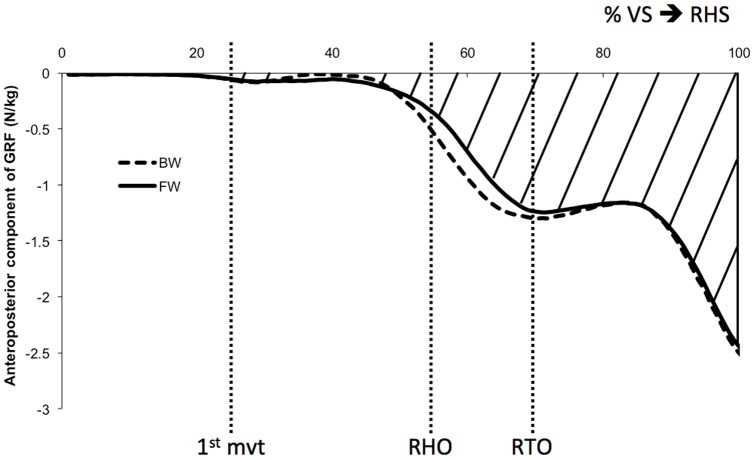
Antero-posterior component of the ground reaction force under the stance limb (left) for the BW group (dashed line) and the FW group (solid line).It was normalized temporally between the appearance of the visual signal (VS) and the right heel strike (RHS), and in amplitude in terms of the subjects' body mass. The hatched surface illustrates the antero-posterior impulse for the FW subjects, using the surface calculated under the curve between the first variation of the ground reaction force and the right heel strike. 1st mvt: first knee movement (26% of the motor task); RHO: right heel off (55%); RTO: right toe off (68%). The average standard deviations for the BW and FW subjects are 0.1 N/kg. There is no significant difference between the two groups (p>0.05).